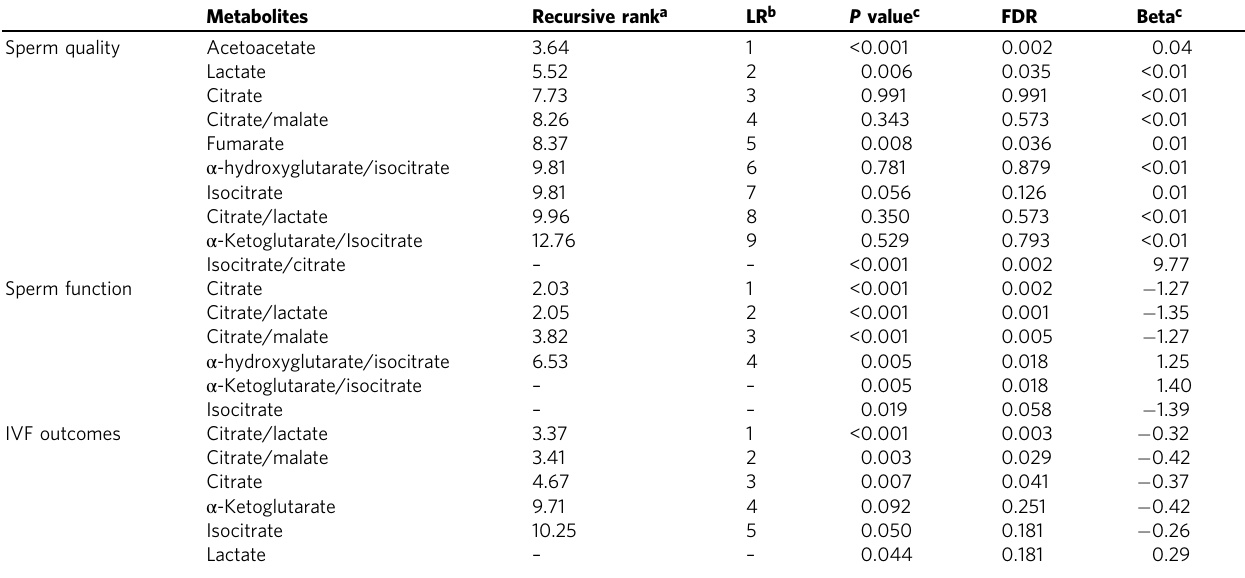
Table 1 Metabolites associated with sperm physiology and in vitro fertility in the PLS models.